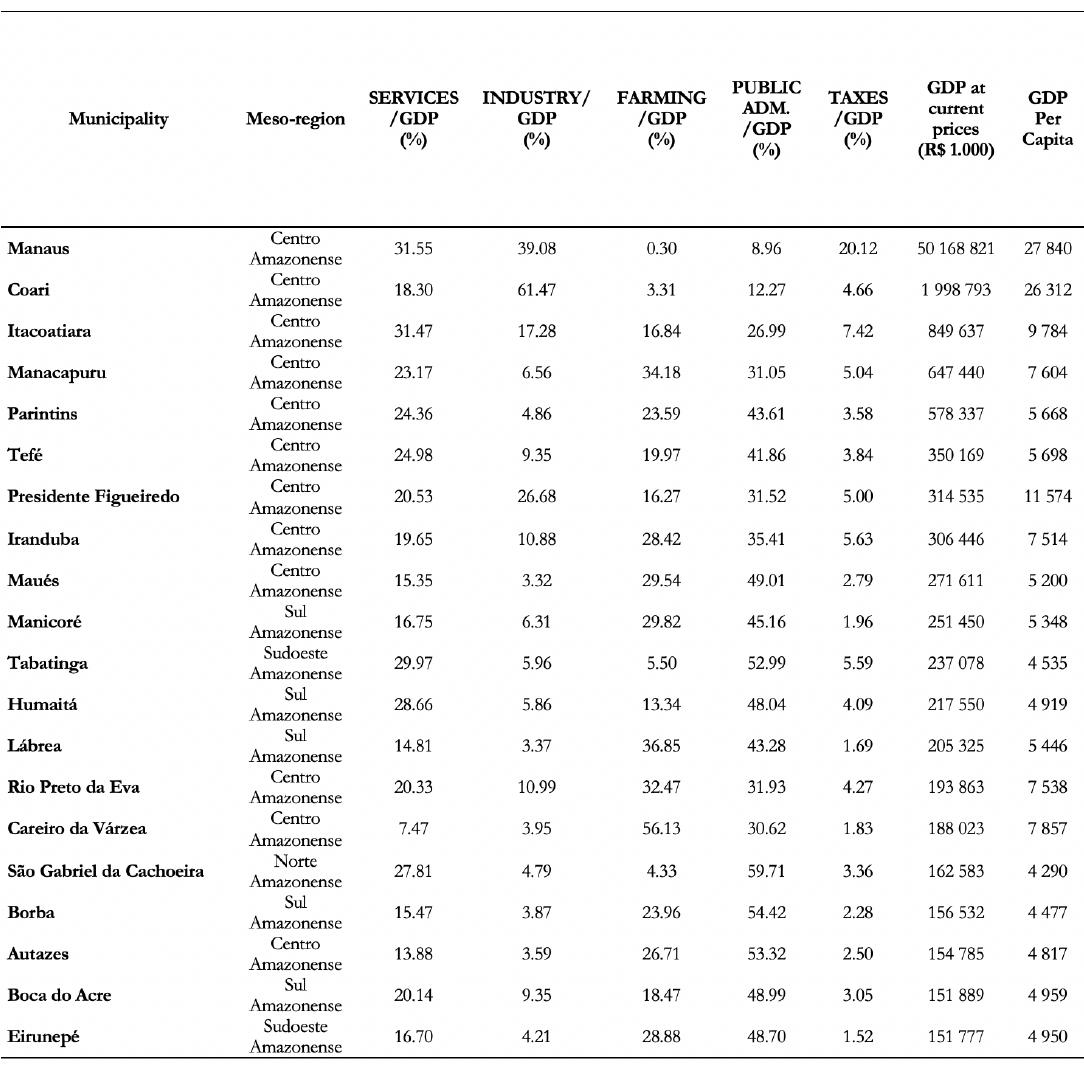
Table 6: Gross Value Added / GDP by sector, GDP and per capita GDP (2010) - 20 municipalities with the highest GDP in the state of